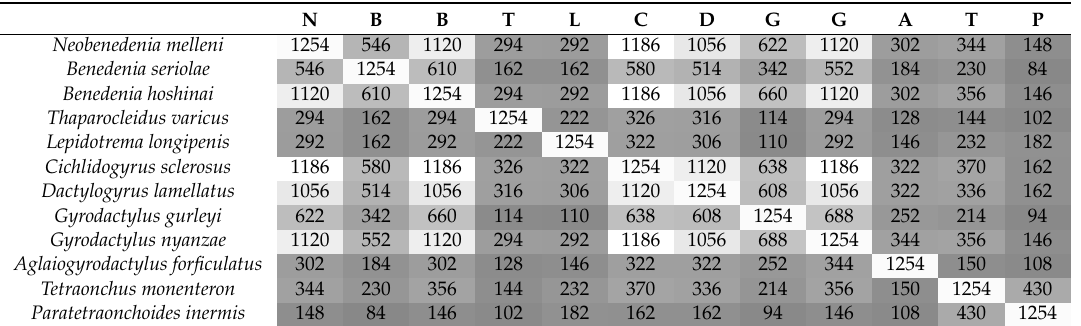
1120 1120 294 146 Aglaiogyrodactylus forficulatus 302 184 302